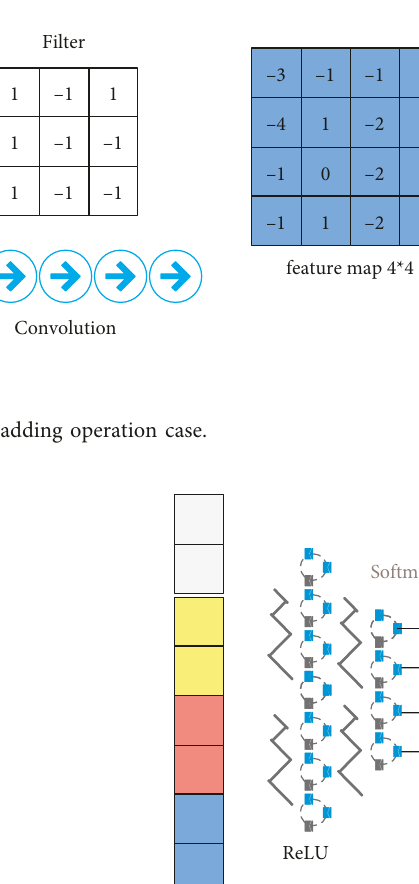
Figure 10: Flatten process. Figure 11: Schematic diagram of fully connected layer. Commonly used model performance indicators include accuracy (Accuracy), precision (Precision), recall (Recall), and Fl value.